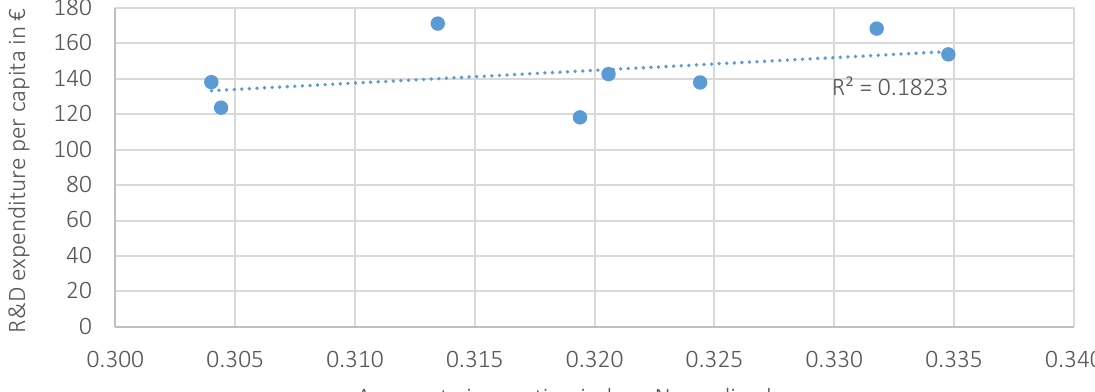
Figure 2. Correlation analysis – Slovakia